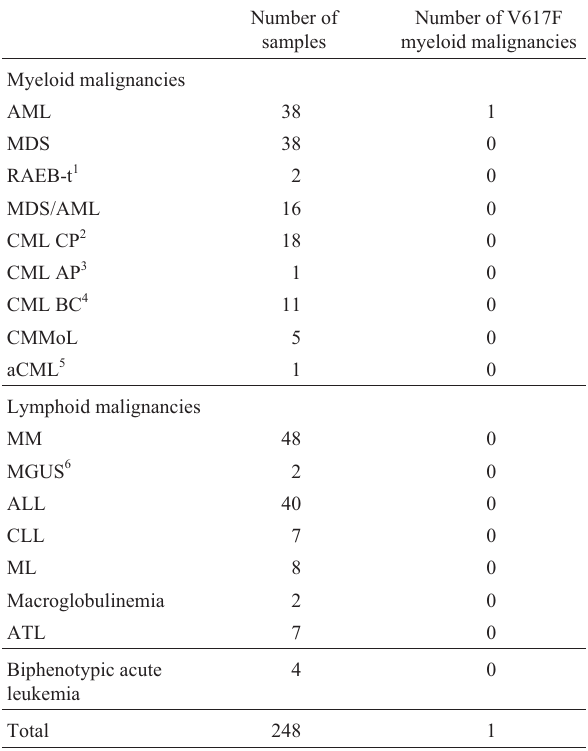
Table 1 - JAK2 V617F mutations in hematological neoplasms. Number of